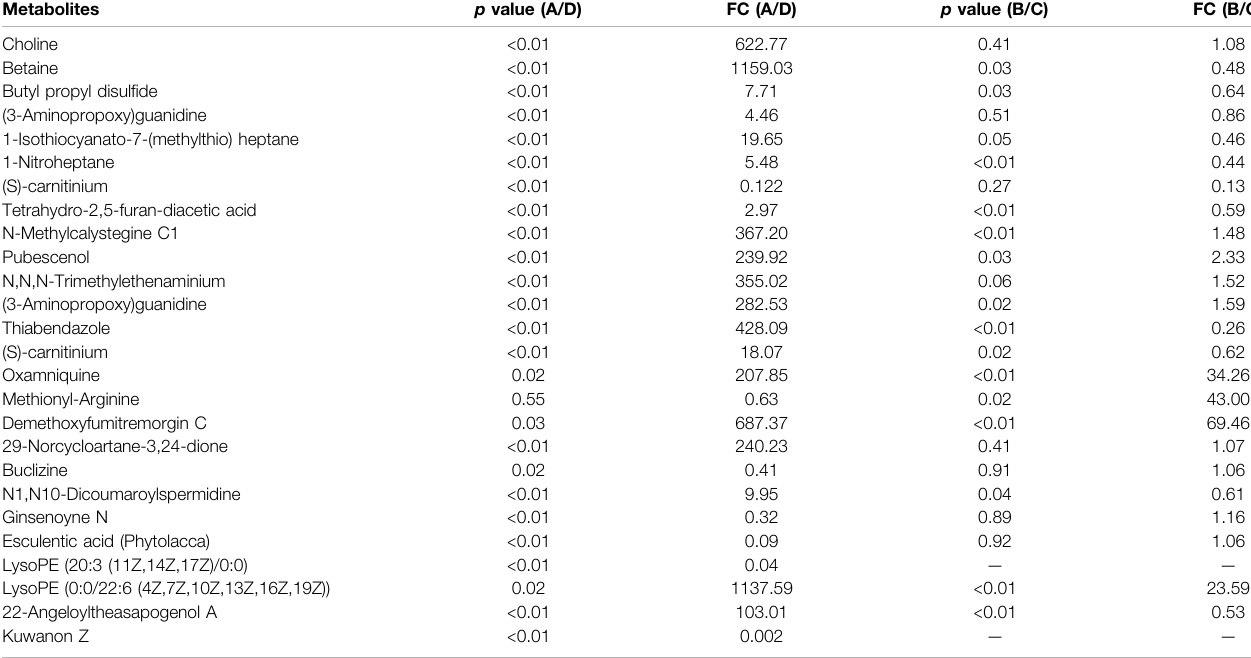
TABLE 3 | Differences in serum metabolites between groups of ALL and AML and between groups of acute myeloid leukemia. Metabolites p value